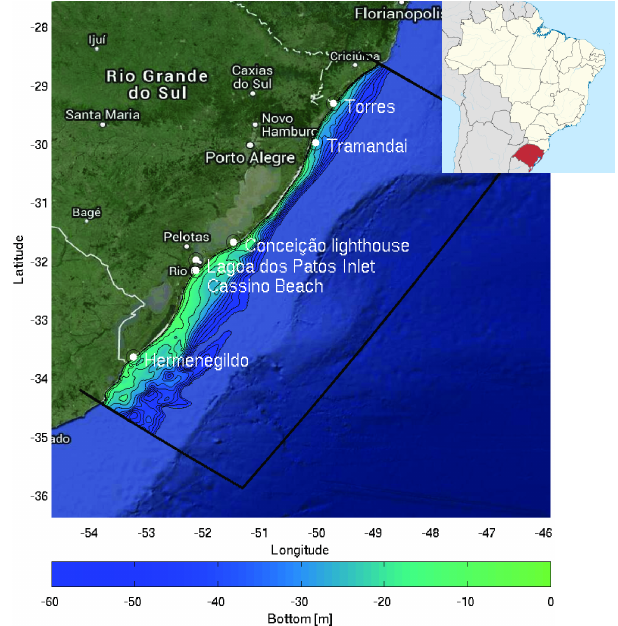
Figure 1. Study field representation. Solid lines represent the the grid boundaries. Inside, on the color scale, the grid bathymetry is between 0 and − 60m. The points indicate reference beaches at Rio Grande do Sul. Tramandaí beach is where the buoy was placed for the comparison analysis. The maps are plotted over a Google Maps